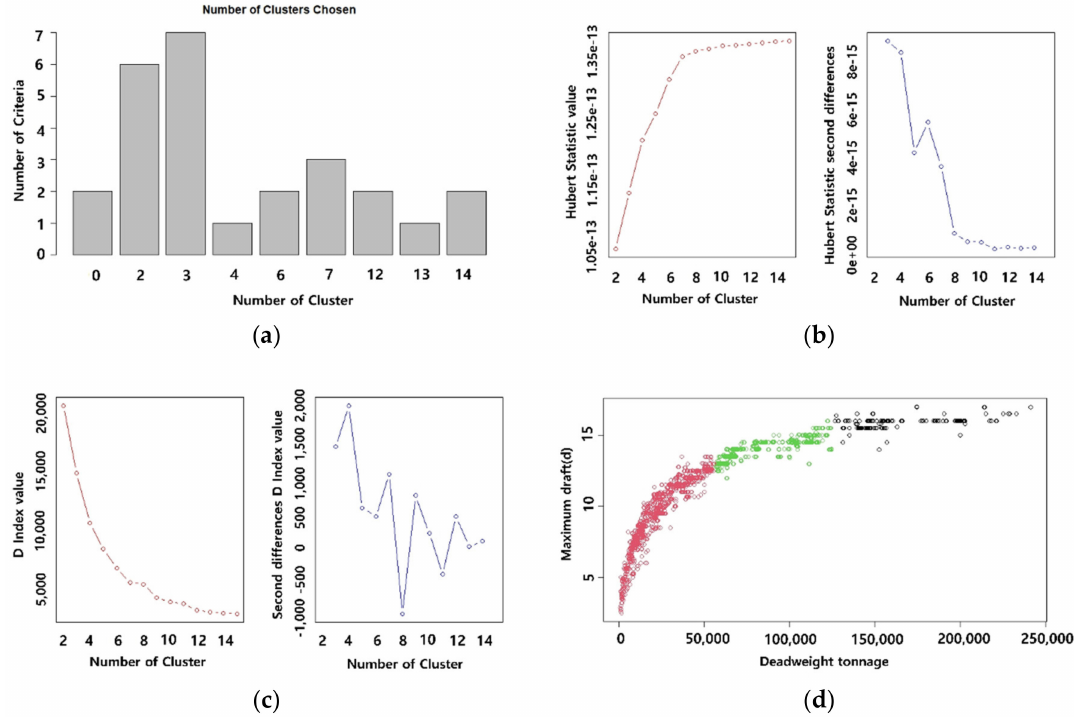
Figure 11. Results of k -means clustering on container ship deadweight tonnage–draft (m). ( a ) Number of clusters selected by NbClust; ( b ) Hubert statistic values; ( c ) D index value; ( d ) scatter plot clustered into three